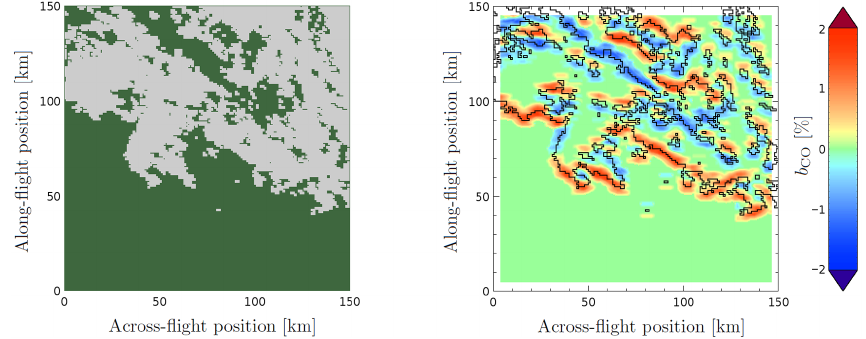
Figure 10. Error due to heterogeneous slit illumination due to a cloudy scene over Australia, 12 February 2010. Left panel: cloud mask derived from MODIS Aqua observations at 1 × 1km 2 spatial sampling (green indicates clear sky pixels; gray indicates cloud flagged pixels). Right panel: CO retrieval bias due to heterogeneous illumination of the instrument entrance slit. The cloudy areas are indicated by the black contour line.